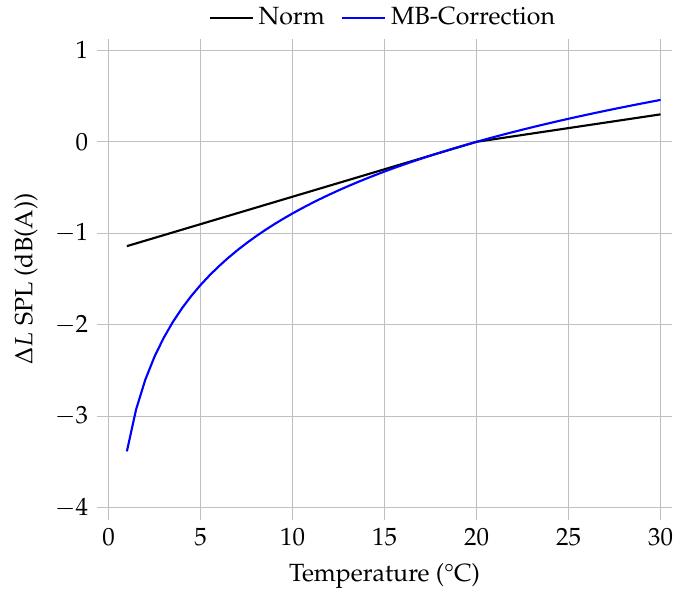
Figure 5. Two different temperature correction curves for absolute SPL, reference temperature is 20 °C.